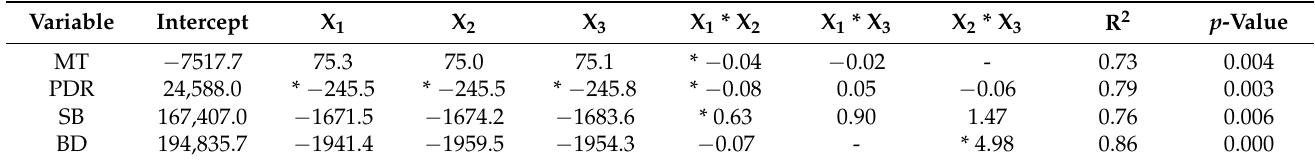
Table 3. Significance and regression coefficients of the prediction